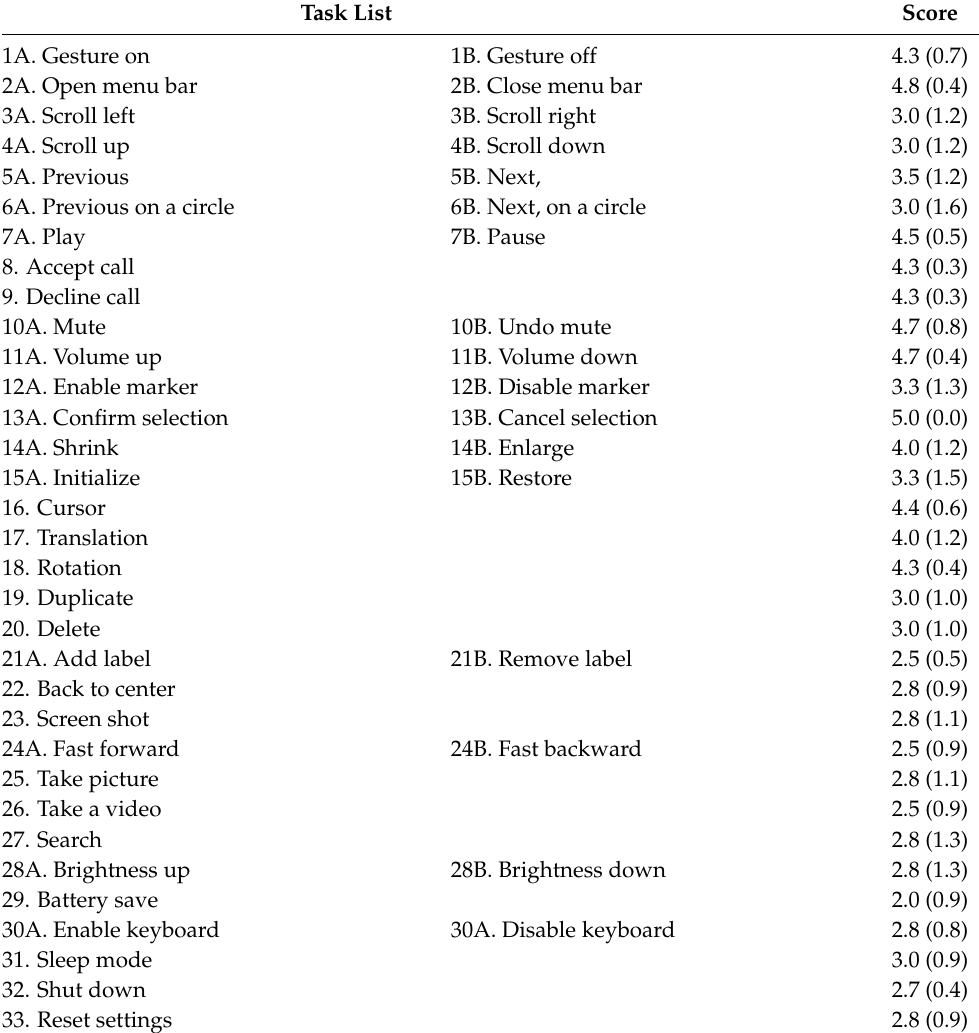
Table 1. Thirty-three commands with mean ( SD ) ratings by experts on their importance for using AR or VR systems (Likert Scale: 1 = least important, 5 = most